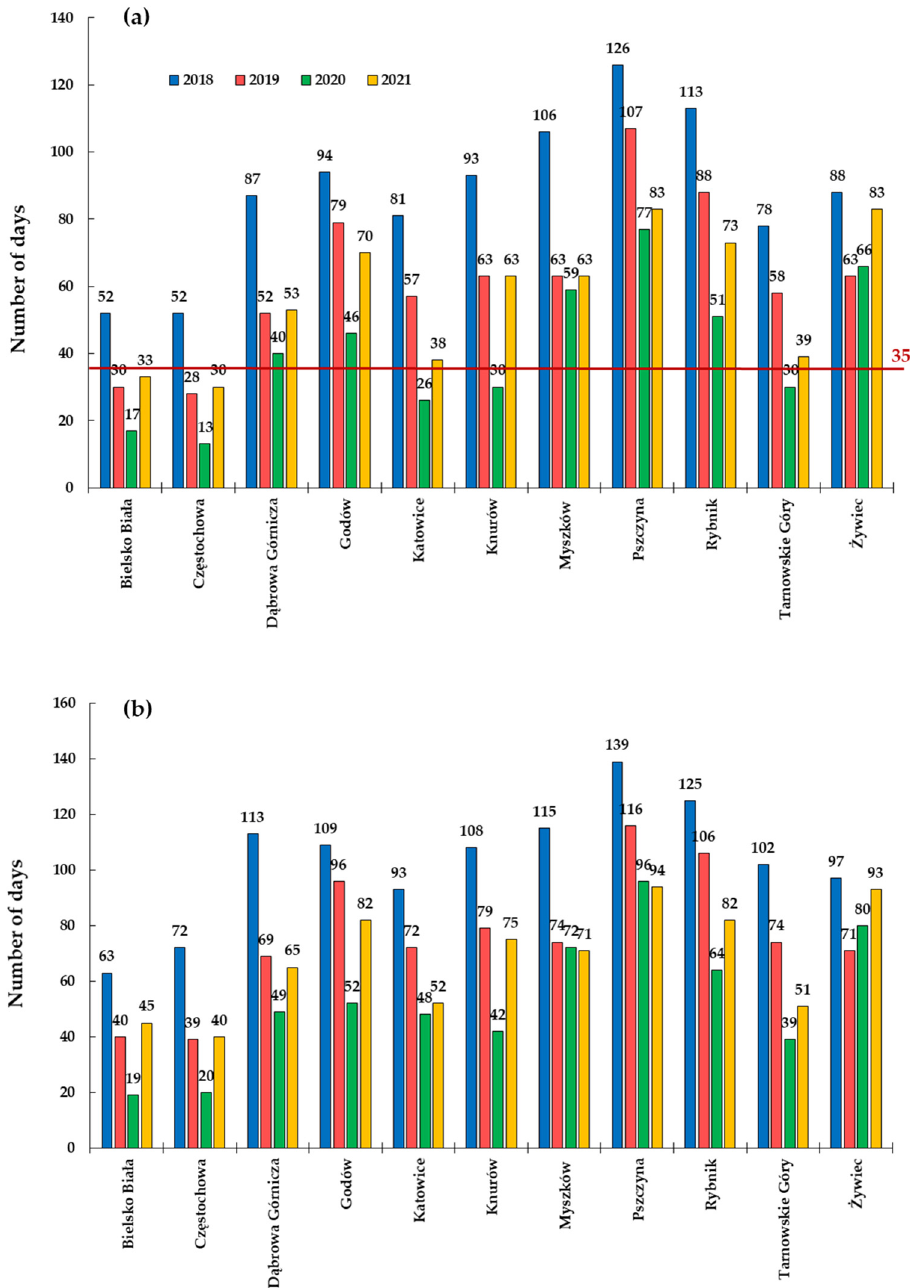
Figure 4. Number of days exceeding the values of the recommended daily average concentrations of PM10 ( a ) according to national standards and ( b ) according to the WHO in Poland. Table 1. The PM2.5/PM10 ratio in the period of 2018–2021 by heating and non-heating seasons.